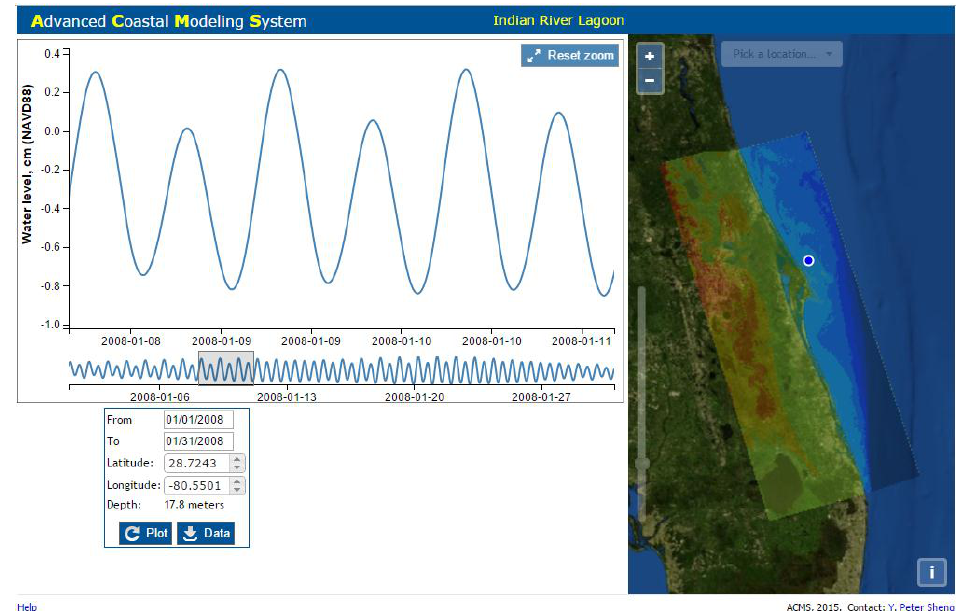
Figure 3. Sample ACMS web-based interface for data preview and download developed for St.